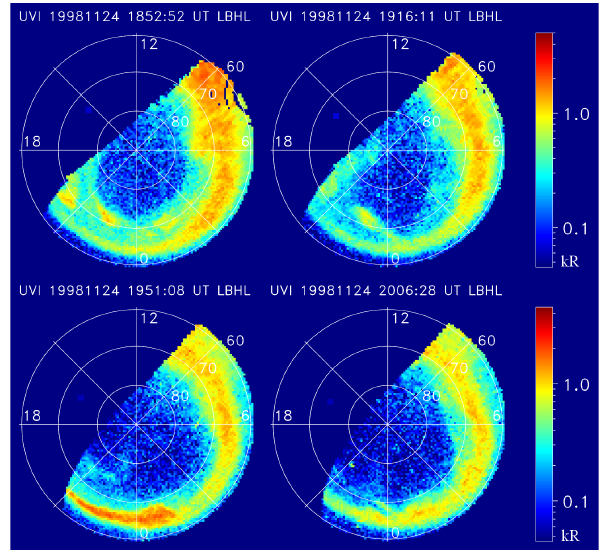
Fig. 5. Polar UV images taken in the LBH long mode for the 24 November 1998 oval-aligned substorm recovery arc (same event as DMSP data shown in Figs. 3 and 4). The DMSP F13 satellite track reaches 89 degrees magnetic latitude at the noon-midnight meridian and is on the dayside of the dawn-dusk